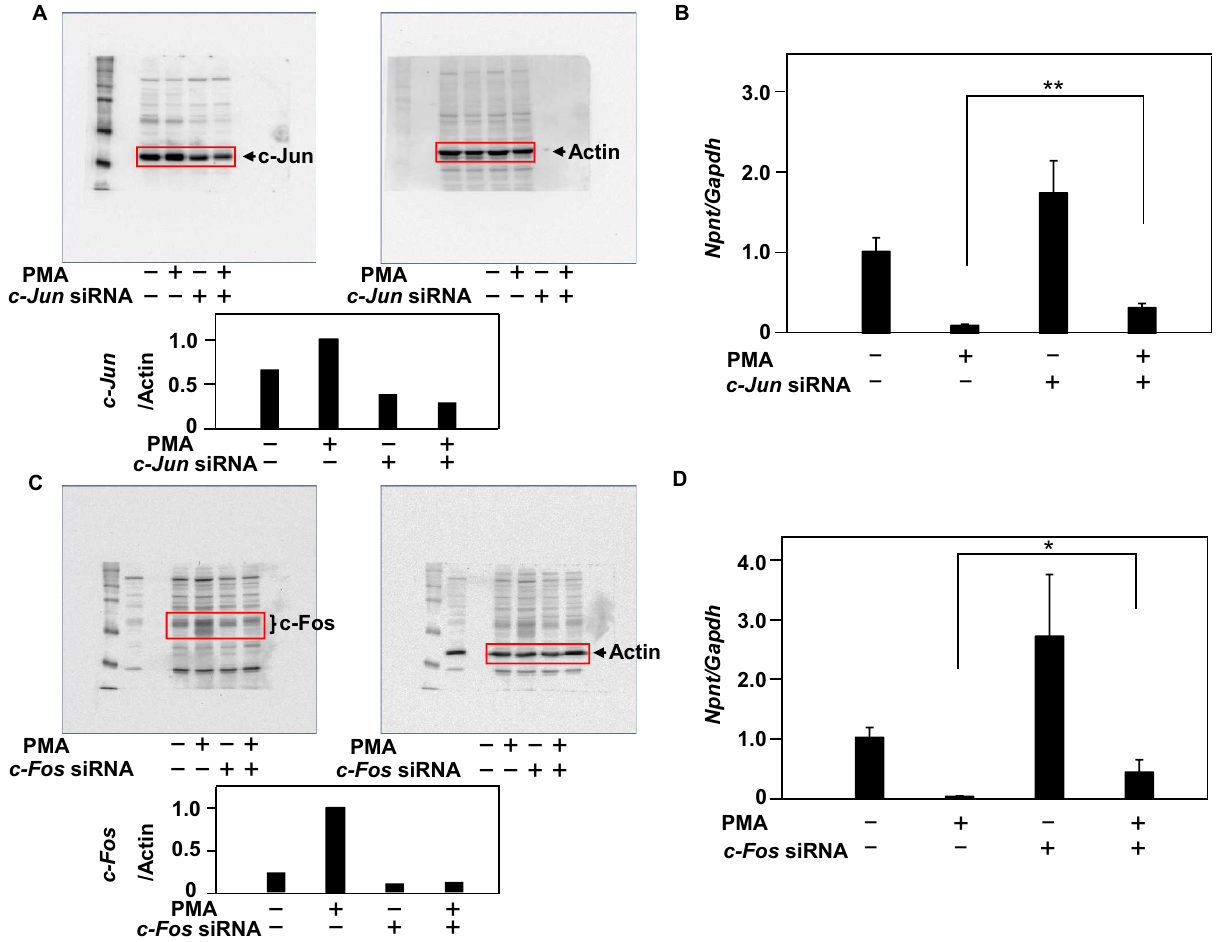
Figure 5. Npnt gene down-regulation by PMA regulated via c-Jun and c-Fos transcription factors. MC3T3-E1 cells were pretreated with or without c-Jun siRNA (20 nM) or c-Fos siRNA (20 nM) for 24 h, and then treated with PMA (100 nM) alone or in combination for 24 h with c-Jun or for three hours with c-Fos . ( A ) Proteins were extracted and subjected to western blotting to detect c-Jun and actin. ( B ) Total cellular RNA was extracted, and mRNAs for Npnt and Gapdh were examined using real-time PCR analysis. ( C ) Proteins were extracted using the same procedures shown in ( A ) and ( B ), and subjected to western blotting to detect c-Fos and Actin. ( D ) Total cellular RNA was extracted, and mRNAs for Npnt and Gapdh were examined using real-time PCR analysis. Results are shown as the mean ± SD of three samples. * P < 0.05, ** P < 0.01, Student’s t-test, as compared to presence or absence of PMA, c-Jun siRNA, and c-Fos